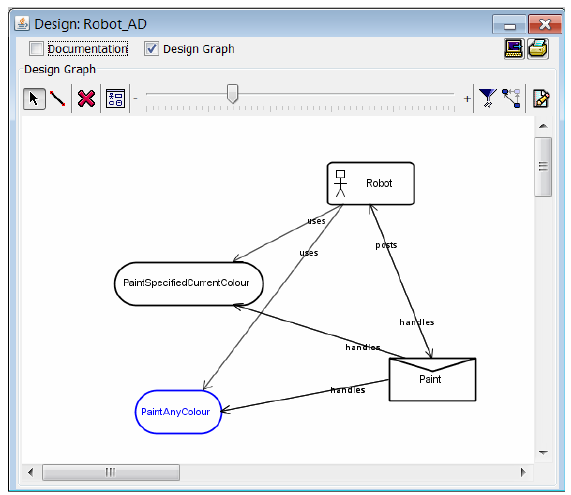
Figure 1. Graphical representation of a Jack robot agent with two plan types responding to an event, Jack practicals.